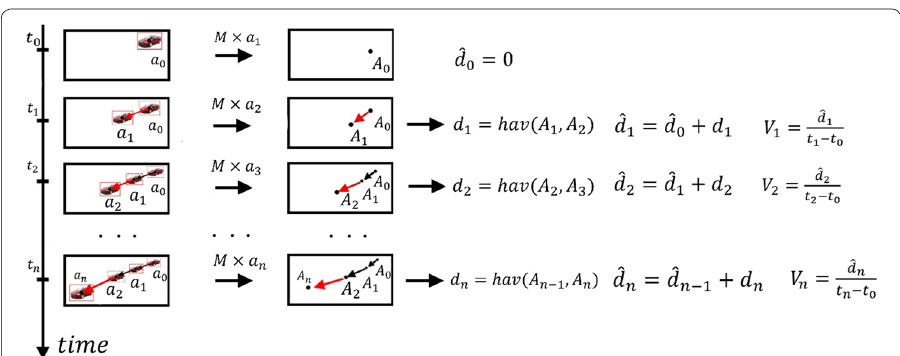
Fig. 15 The process for determining the distance and